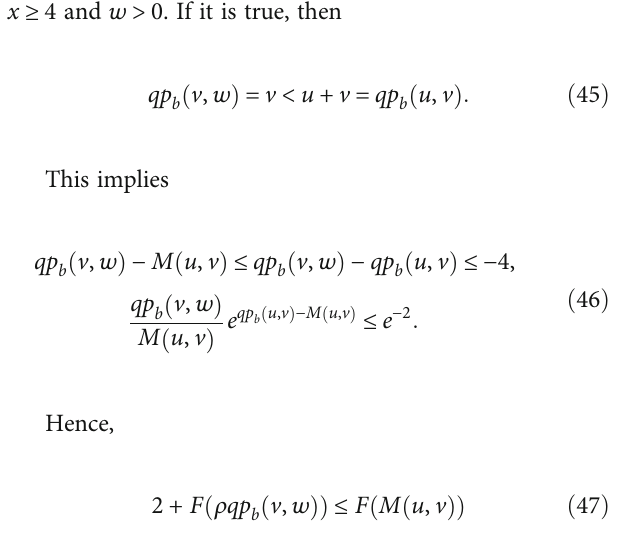
: X × X ⟶ ½ 0, ∞ Þ and qp b